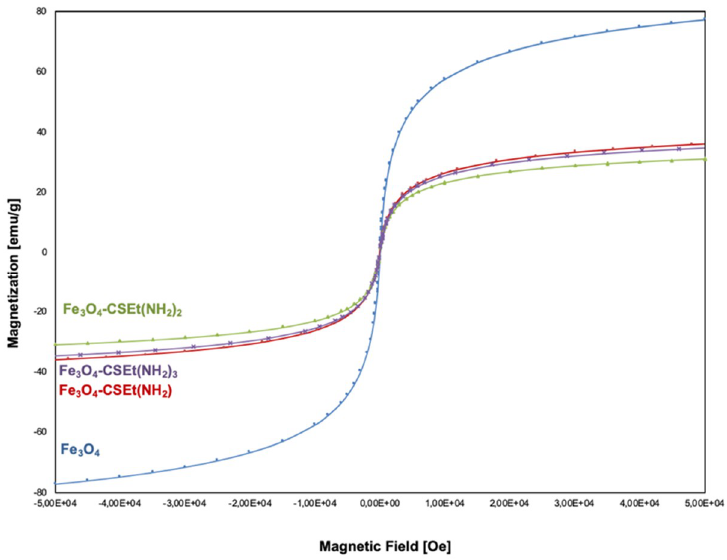
Figure 6. Magnetization hysteresis curve for aminated chitosan-coated nanoparticles Fe 3 O 4 -CSEt(NH 2 ) 1–3 and naked nanoparticles (Fe 3 O 4 ). Table 2. Contact angle measurement results for modified chitosan.